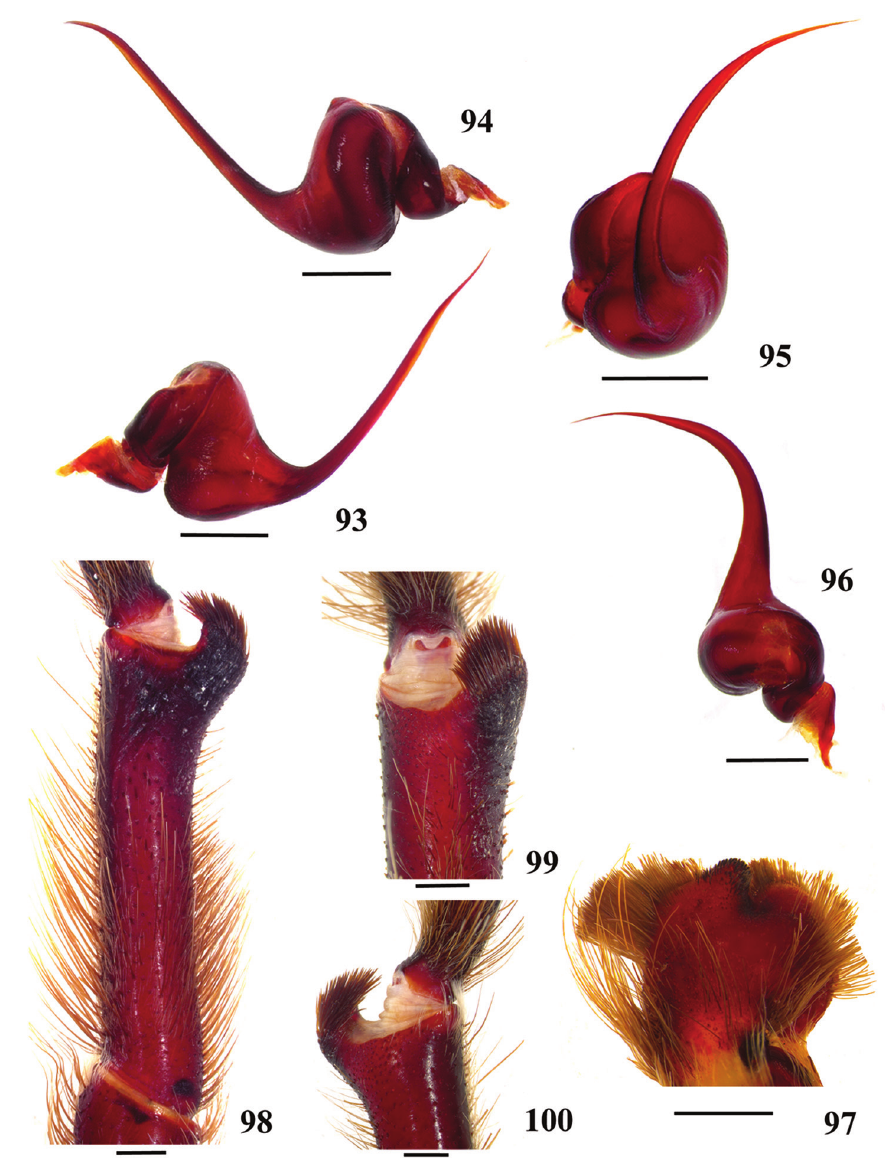
Figures 93–100. Avicularia taunayi (Mello-Leitão, 1920), male (DZUB 1675; except cymbium, DZUB